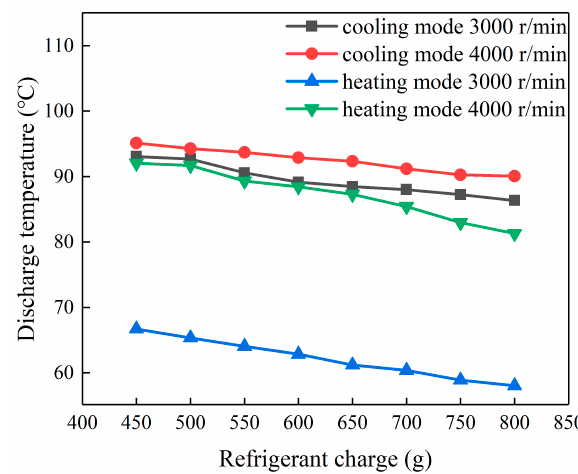
Figure 6. Discharge temperature variations with refrigerant charge.